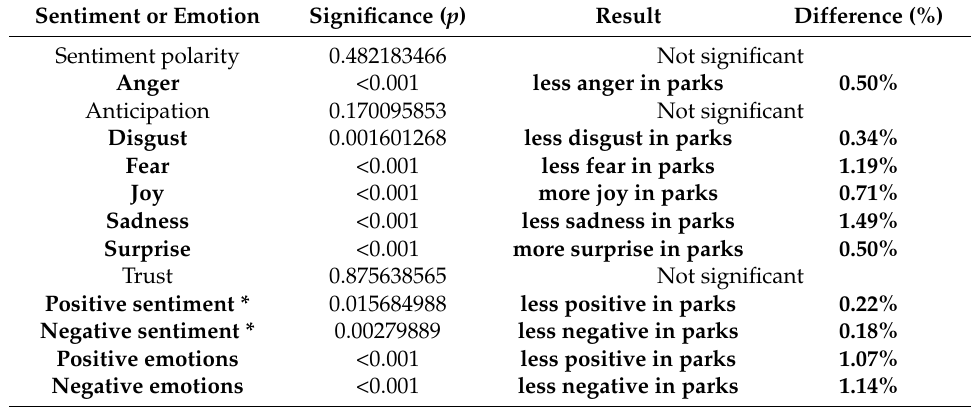
Table 4. Difference between park tweets and non-park tweets for sentiments and emotions.